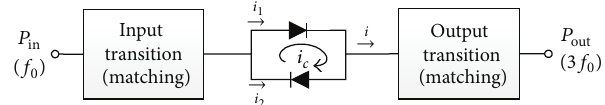
Figure 1: Block diagram of the proposed frequency triplers.